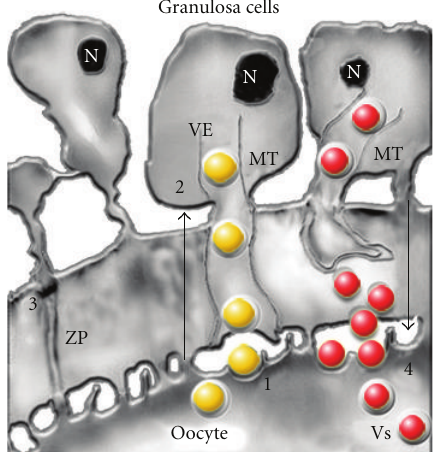
Figure 2: Model proposing regulated delivery of the paracrine factors to the oocyte-granulosa cell interface [6, 7]. Four commu- nication pathways are described. (1) Localized uptake of growth factors, like GDF-9, from the oocyte (yellow ball) by endocytosis at attachment sites of transzonal projections (TZPs) at the oolema. The vectorial transport of endocytic vesicles (VEs) to the cytoplasm of the granulosa cells takes place through the microtubules (MT). (2) Granulosa-zona pellucida interactions are necessary for the orientation of the TZPs. Contact sites may play an important role in the signaling role of oocytes and granulosa cells. (3) The gap junctions that allow direct intercellular communications between the microvilli of the oocyte and the granulosa cell TZPs. (4) Pathway for delivery of granulosa cell factors (red ball) packaged in secretory vesicles (VSs), which undergo endocytosis through the specific receptor on the oocyte surface. N: nucleus, MT: microtubules, ZP: zona pellucida, red ball: factors of the granulosa cells, yellow ball: factors released by the oocyte. With permission from D. F.